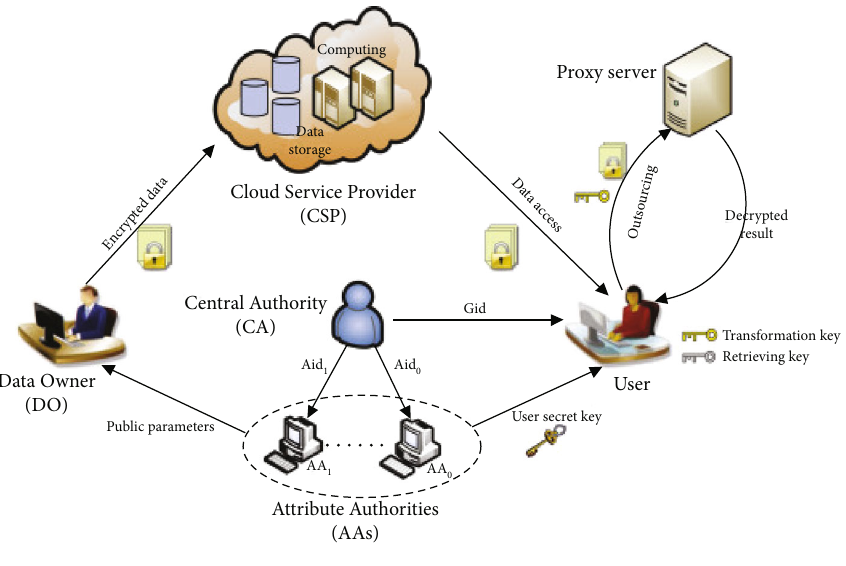
Figure 4: Key usage process.